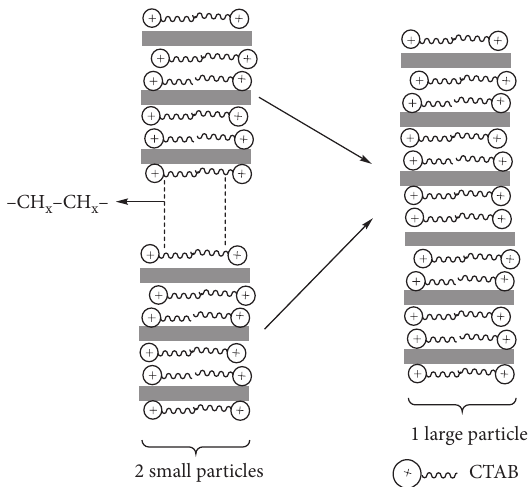
Figure 2: The schematic drawing for illustrating the role of CTAB.